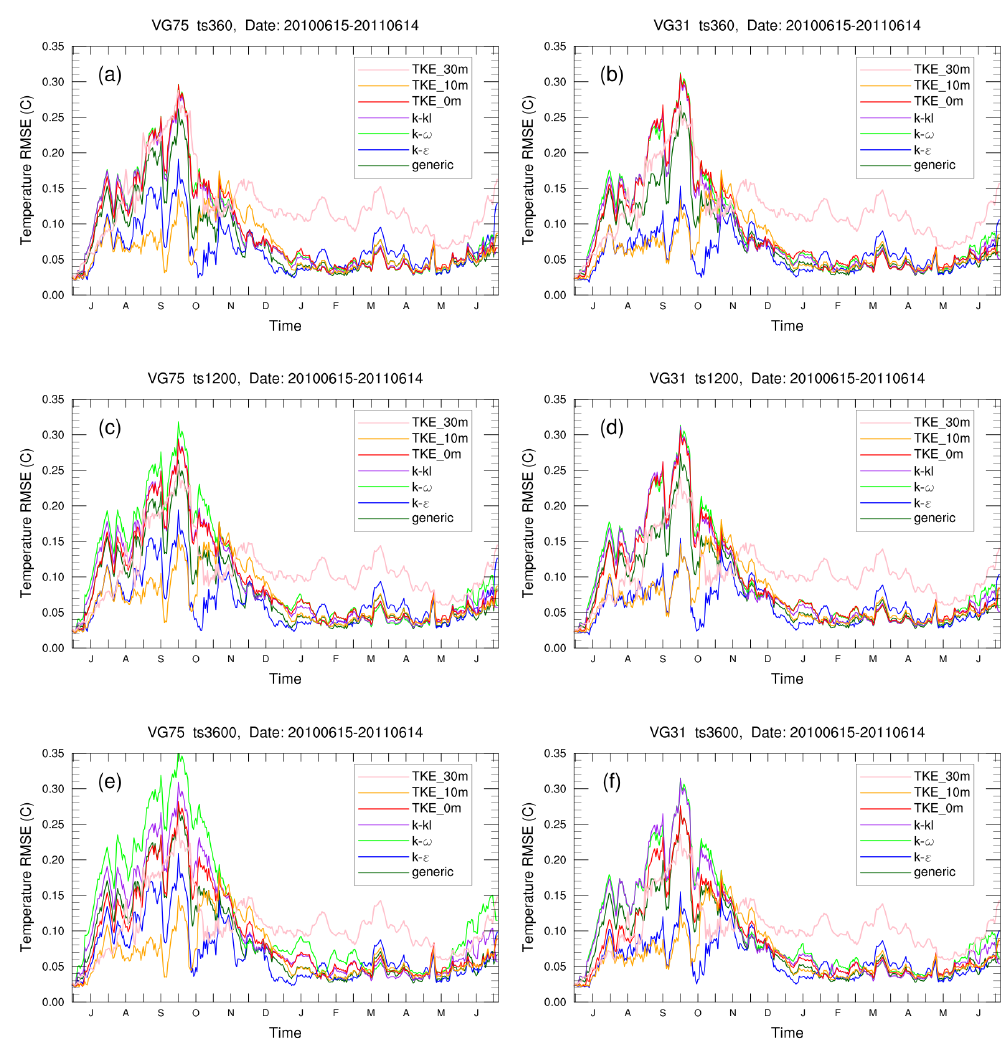
Figure 10. Evolution of the temperature RMSE computed along the vertical (0–120m) for the pairs [L75, 360s] (a) , [L31, 360s] (b) , [L75, 1200s] (c) , [L31, 1200s] (d) , [L75, 3600s] (e) , [L31, 3600s] (f) and different